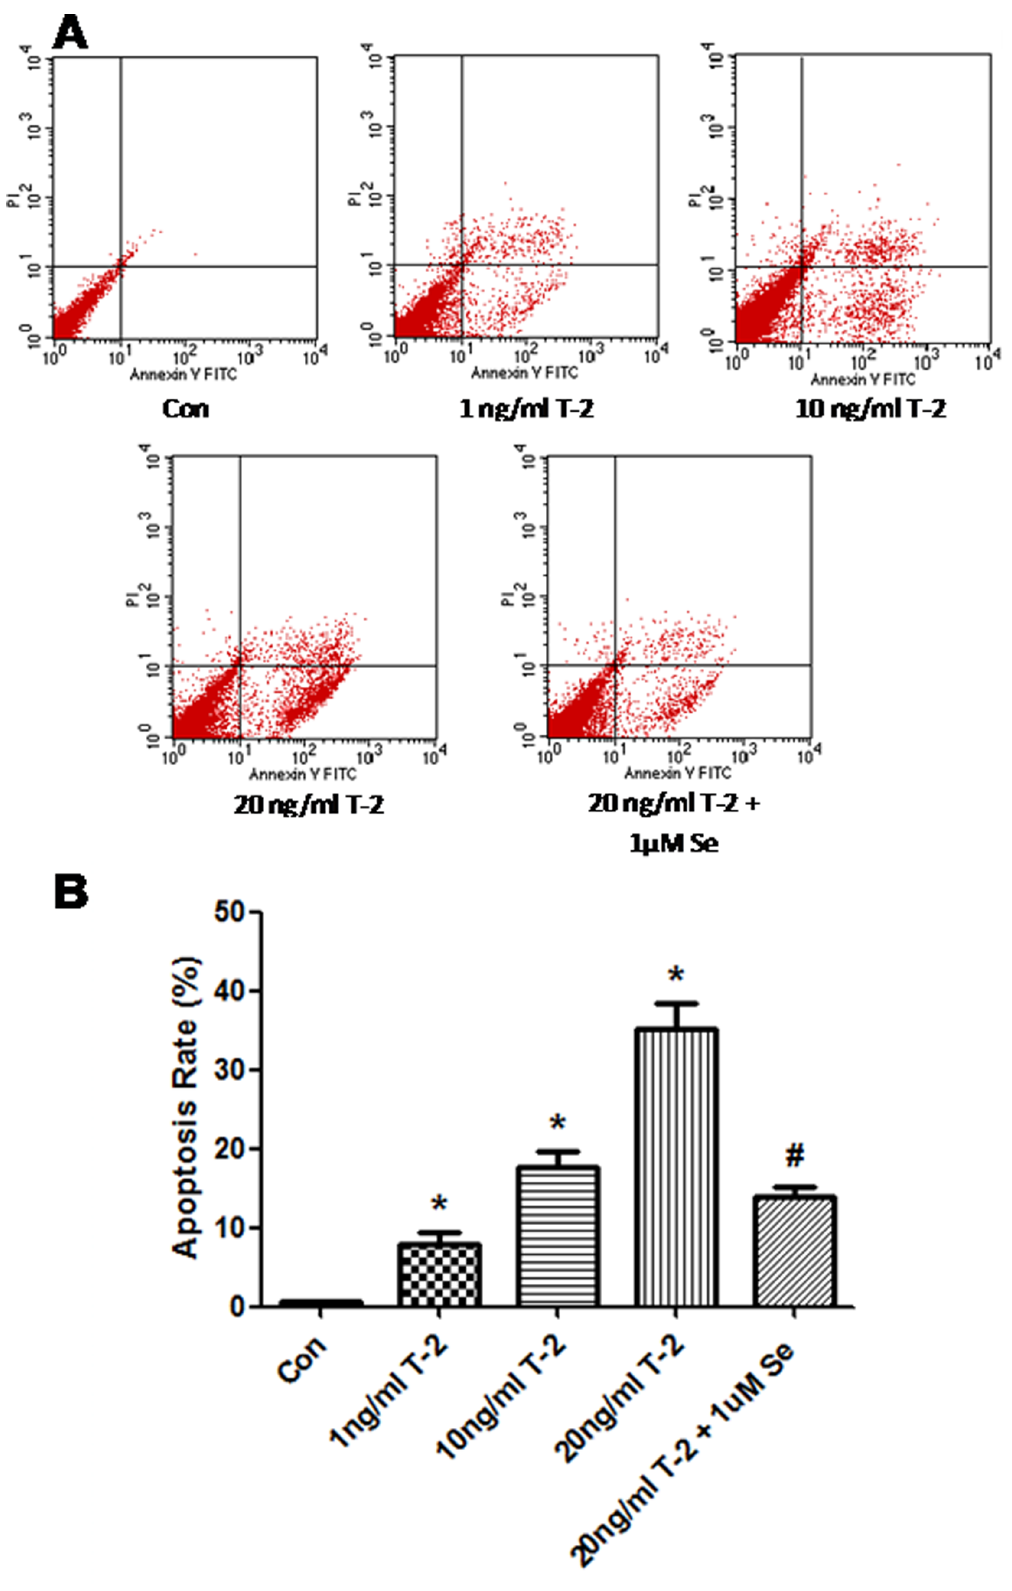
Figure 6. Effect of T-2 toxin on apoptosis in human chondrocytes cultured for 5 days. The apoptosis rate was determined by FCM assay. * P , 0.05 vs. control; # P , 0.01 vs. 20 ng/ml T-2 toxin group.